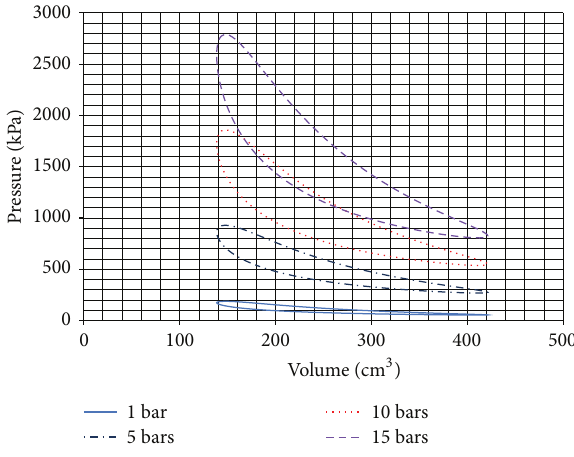
Figure 12: P-V diagram at different operating